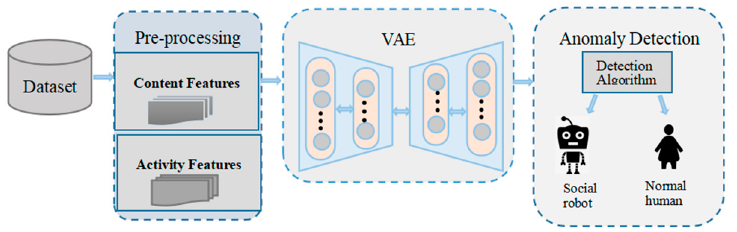
Figure 1. Social media bot detection framework.